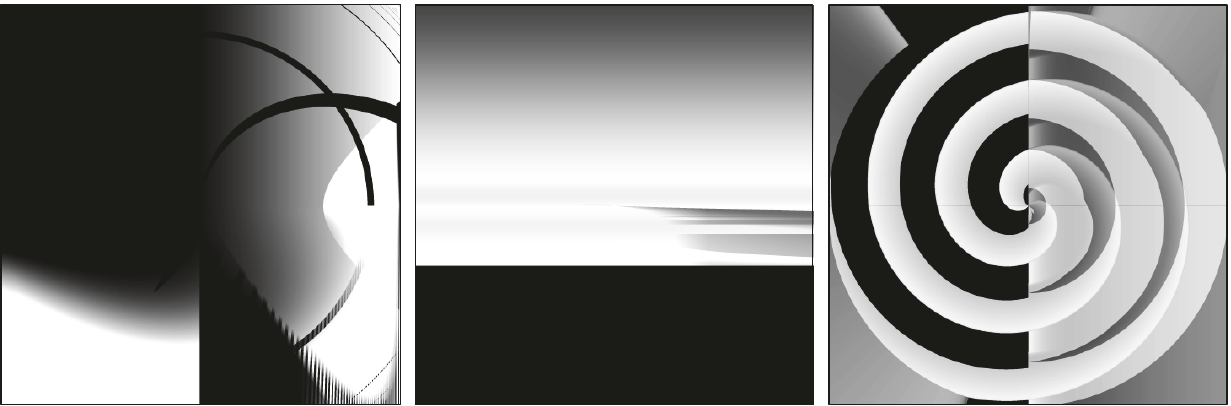
Figure 8: Compositional experiment highlights. Images were produced using targets (from left to right): Composition 01, Composition 09, and Composition 10. Choice of 𝐾 is outlined in Table 4. These examples show fair replication of compositional aspects, including placement of positions of intensity, contrasts and gradients, and shape